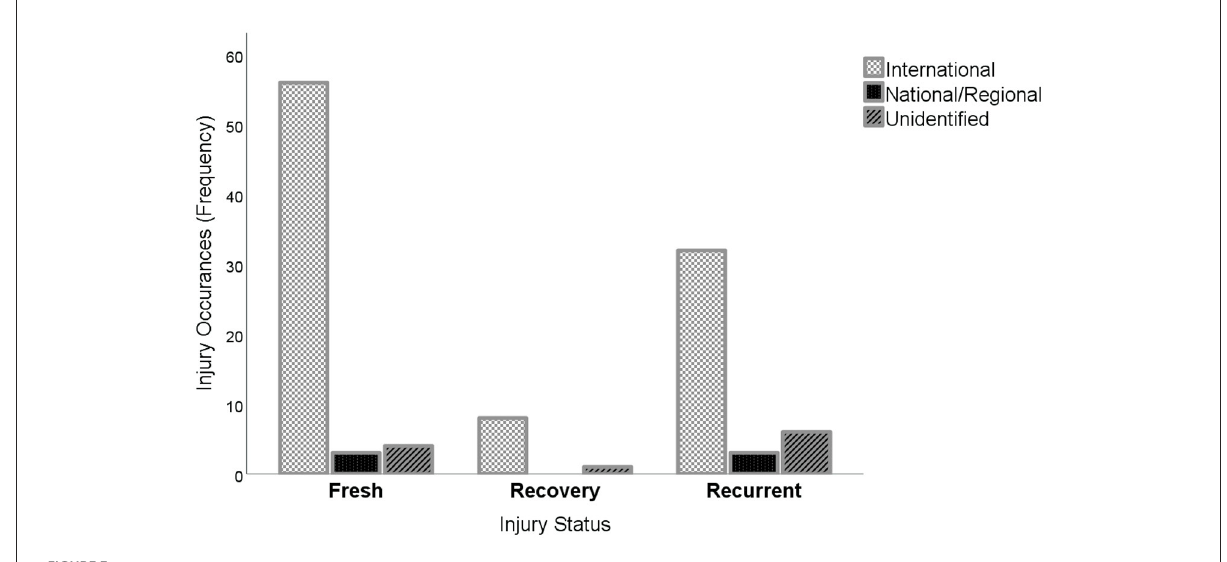
FIGURE3 Types of tournaments and injury status.